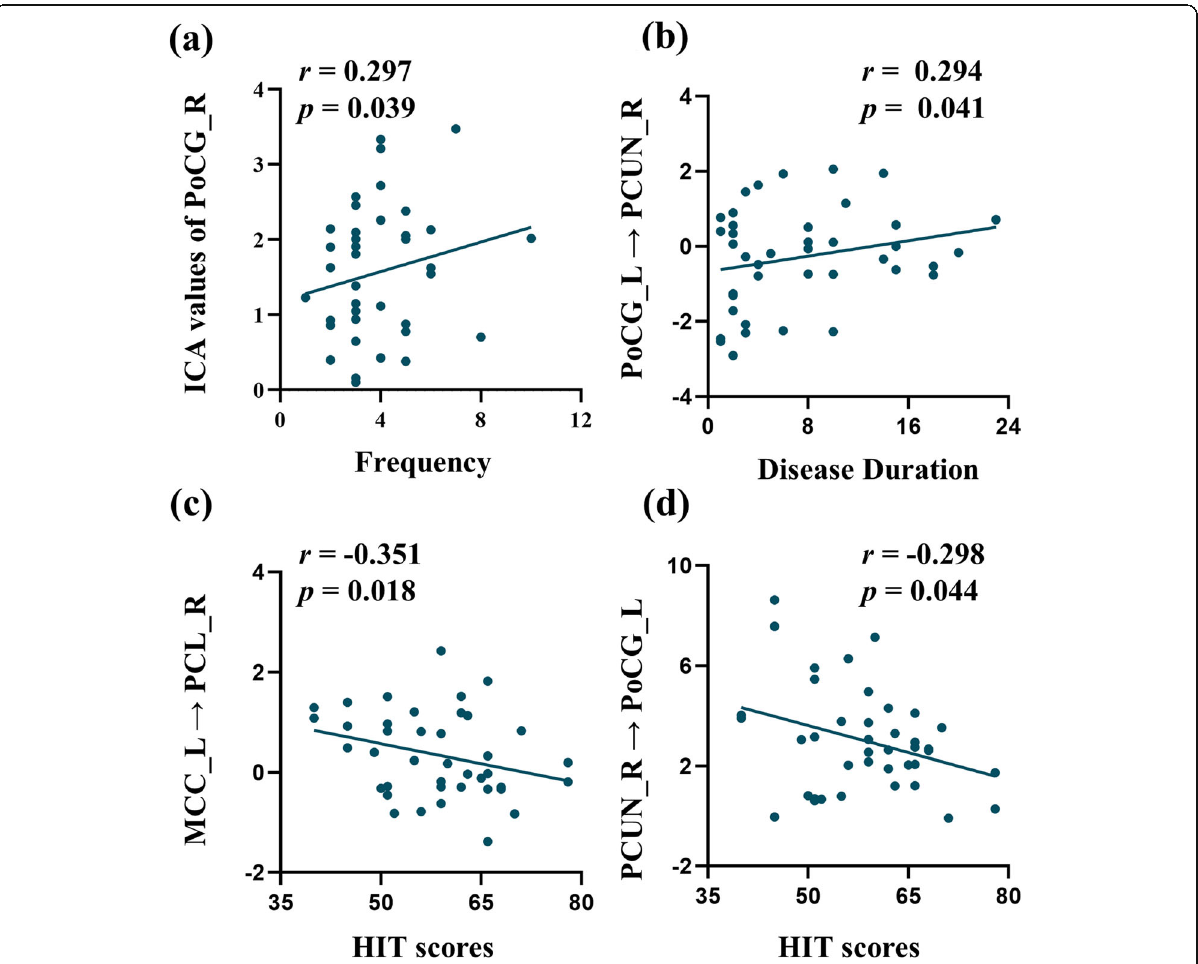
Fig. 3 Significant correlations between clinical characteristics and abnormal connectivity in migraineurs without aura. HIT: headache impact test; ICA: independent component analysis; MCC: midcingulate cortex; PCL: paracentral lobule; PCUN: precuneus; PoCG: postcentral gyrus; L: left; R: